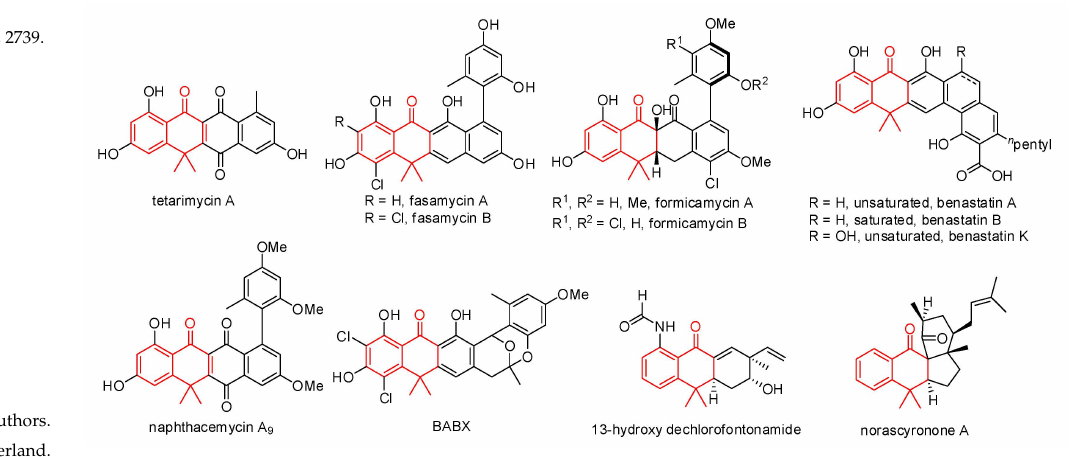
Figure 1. Aromatic polyketides containing a γ - gem -dimethyl-1-tetralone unit. Clinically, only a few antibiotics are able to cope with these resistant strains